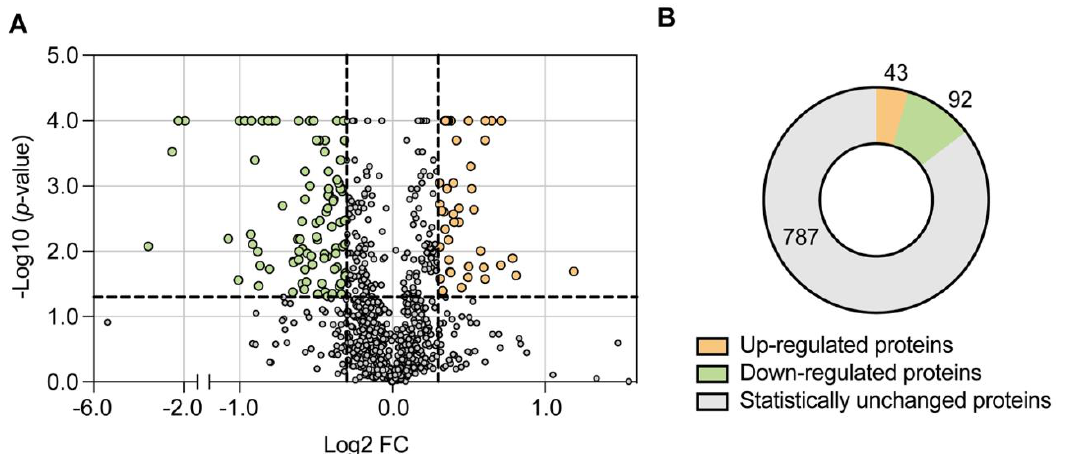
Figure 1. A total of 135 mitochondrial proteins exhibited significantly altered abundance in Cdh1p- deficient cells. ( A ) Volcano plot showing differentially expressed proteins in cdh1 ∆ mutant. Log- transformed p -values ( t -test) are plotted against log-transformed fold change (FC). The horizontal dashed line marks a p -value of 0.05. Vertical dashed lines indicate a Log2 FC of ± 0.3. The up-regulated and down-regulated mitochondrial proteins are highlighted in orange and green, respectively. The plot was cropped between -1.4 and -1.2 Log2 FC to improve data visualization. ( B ) Diagram depicting the number of mitochondrial proteins up- and down-regulated in cdh1 ∆ mutant cells.